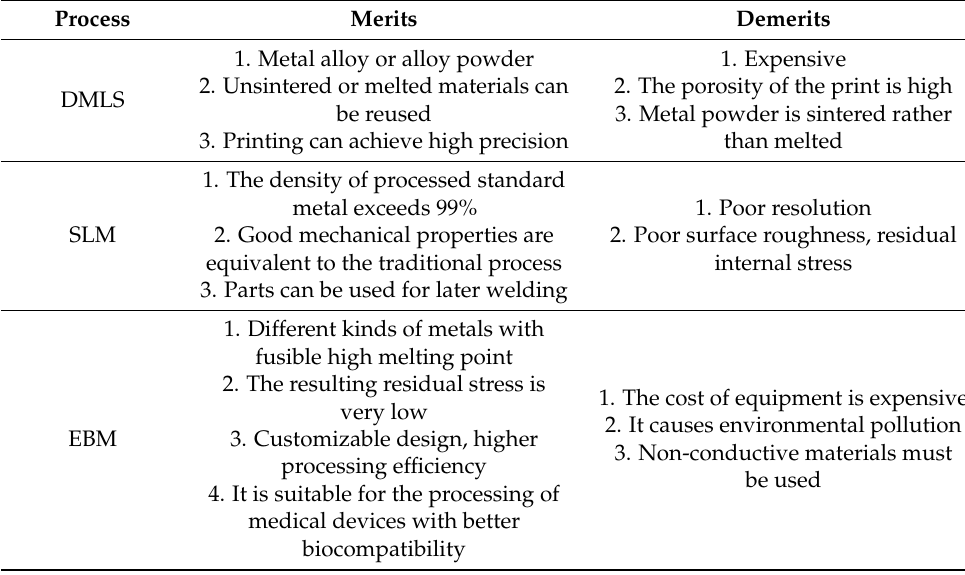
Table 1. Common metal 3D printing processes.